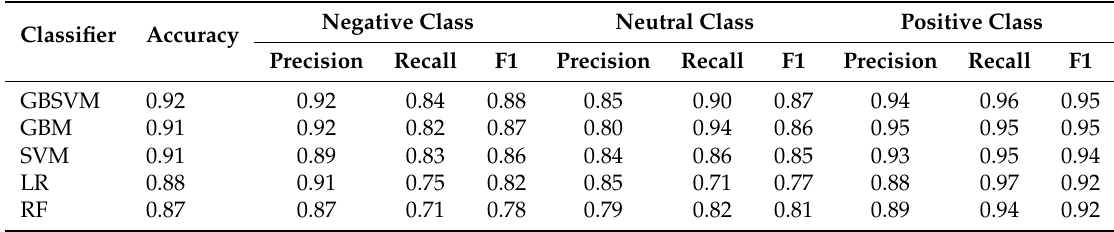
Table 4. Accuracy of classifiers using TF-IDF features.